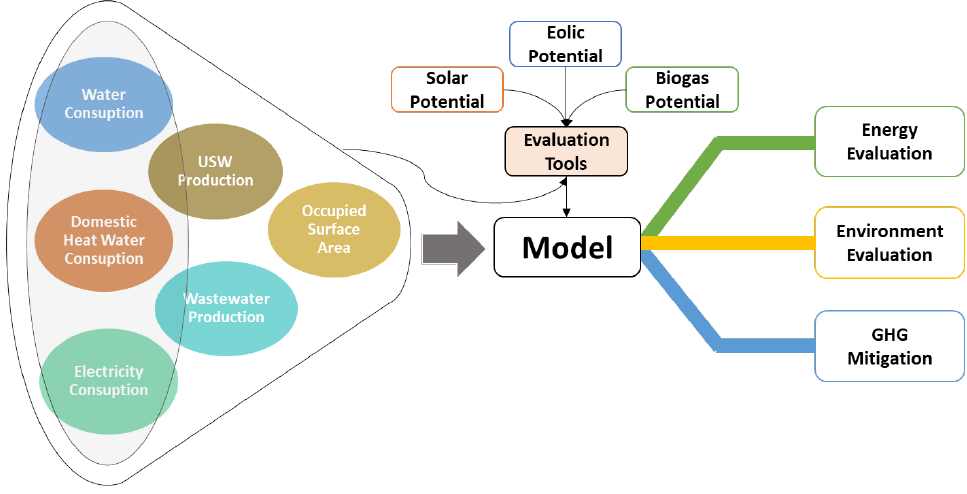
Figure 2. General diagram of the model.